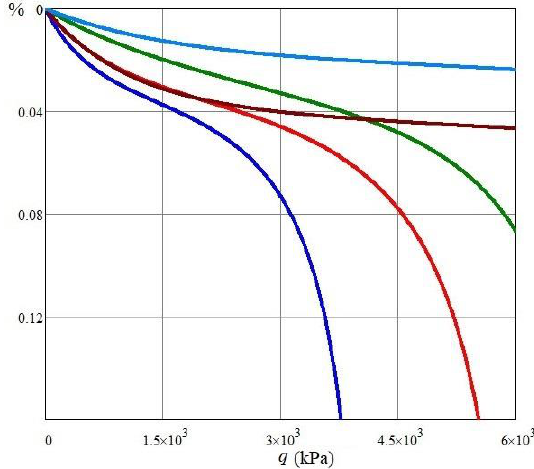
Figure 8. The dependency curve between ε z − 3, calculated using Equation (31) and load q of a soil element at a depth of 5 m with various values of stiffness ( G e , ν , ε ∗ , α ) and strength ( φ , and c) parameters.